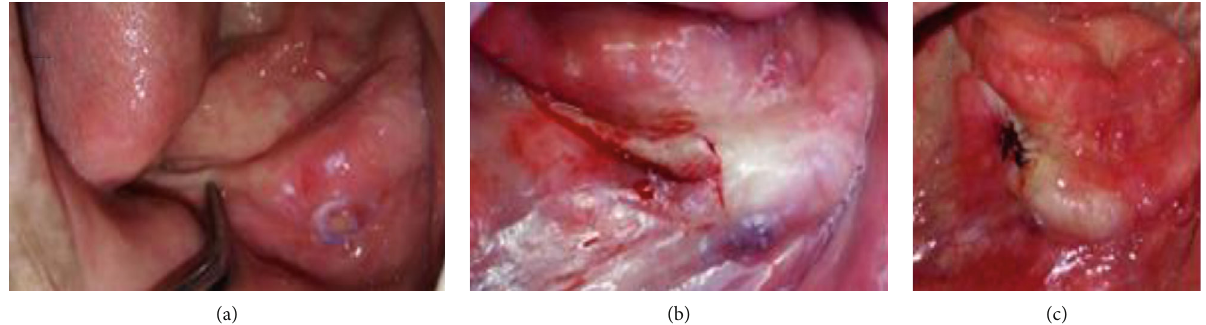
Figure 9: Surgical correction of the disinserted fi bromucosa: (a) clinical examination of the disinserted fi bromucosa and (b, c) surgical treatment.